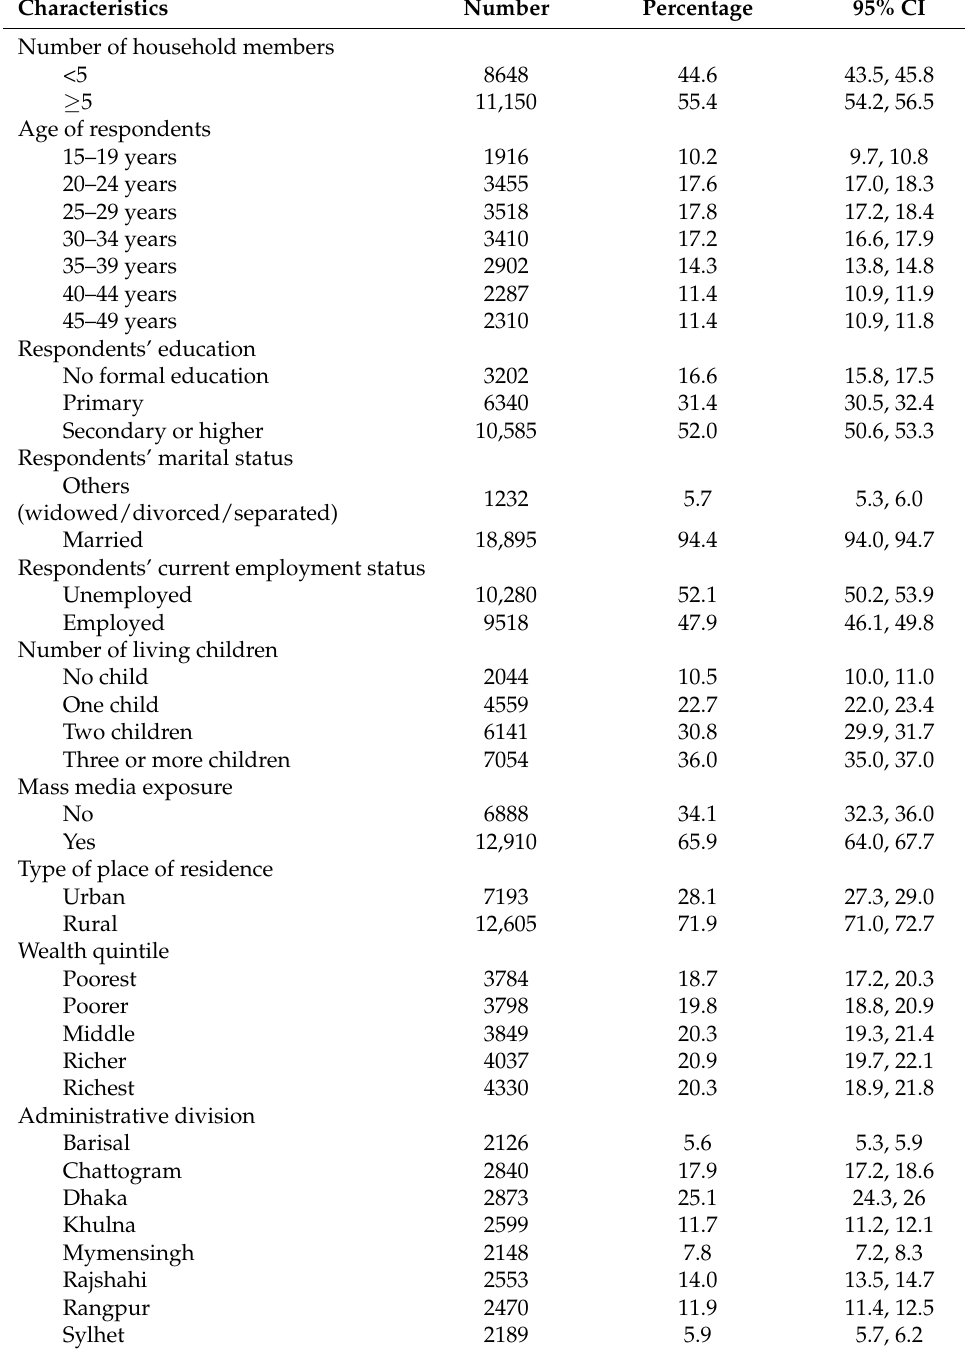
Table 1. Sample characteristics of the study